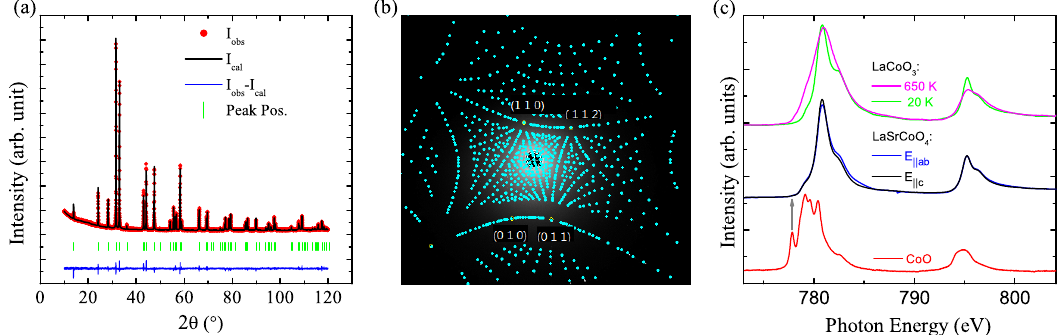
Figure 2. (Color online) ( a ) Rietveld refinement of an XRD pattern of LaSrCoO 4 measured at room temperature; ( b ) Laue diffraction pattern of LaSrCoO 4 . ( c ) X-ray absorbtion spectroscopy (XAS) spectra of LaSrCoO 4 together with reference spectra of a Co 3 + reference sample (LaCoO 3 ) [14] and of another Co 2 + reference sample (CoO). These XAS spectra unambiguously show that our single crystals contain no detectable Co 2 +